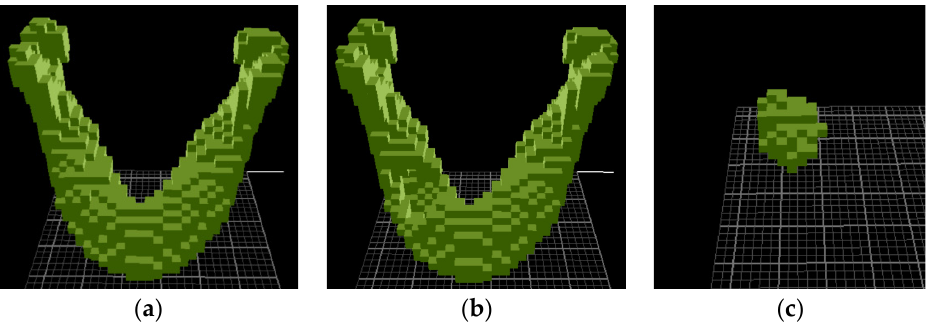
Figure 4. Three-dimensional model with dimensions of 32 × 32 × 32. ( a ) Voxelized 3D model ( b ) Simulated 3D model of defect ( c ) Implant 3D model.